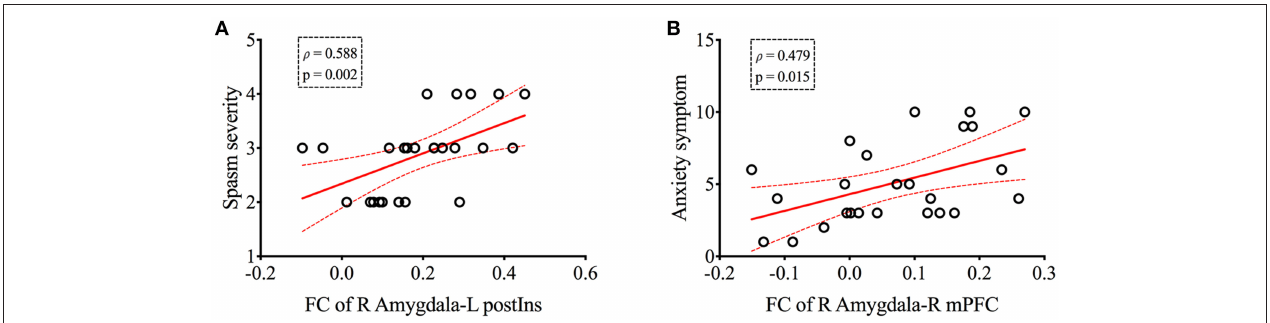
Frontiers in Neurology |